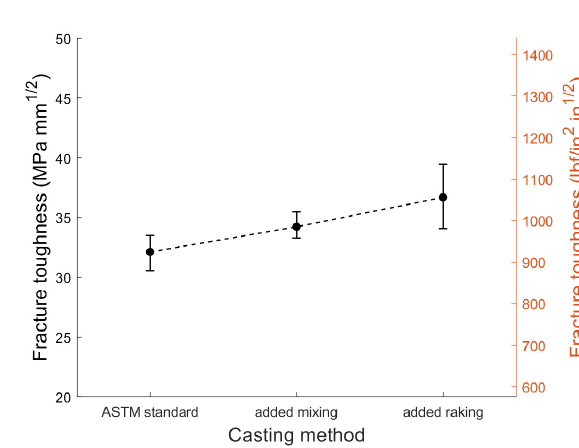
Figure 6. Experimental fracture toughness of concrete beams cast using ASTM standard methods, followed by mixing or raking. The data points indicate the mean and the whiskers show the standard deviation of each sample set.